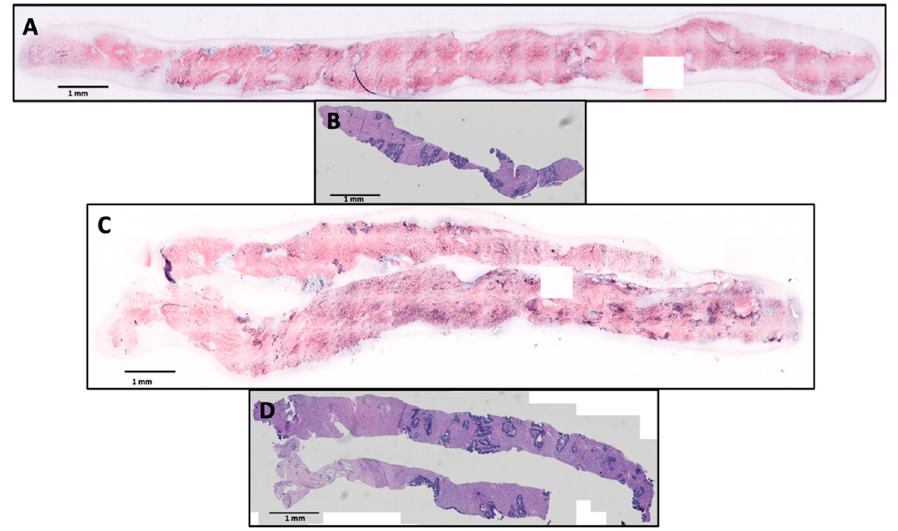
Figure 2. An example of a benign prostate biopsy imaged with SIM ( A ) and the subsequent histology slide (B) and an example of a malignant prostate biopsy with a Gleason score of 3 + 4 ( C ) and the subsequent histology slide ( D ). Images are shown to scale, all scale bars are 1 mm.